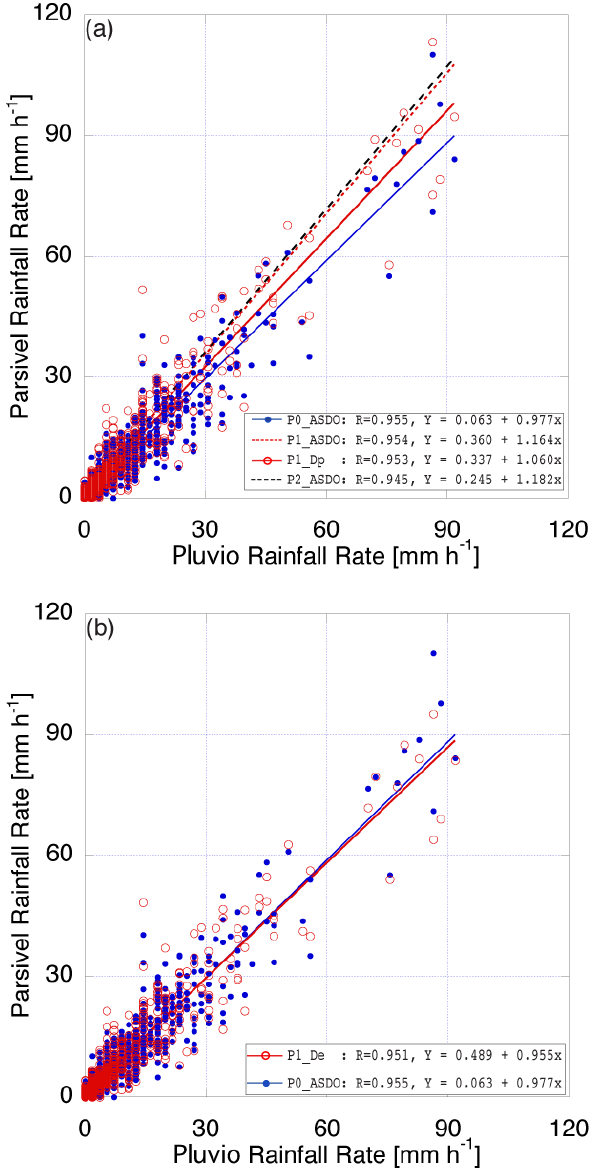
Fig. A1. Scatter plots of the rainfall rate for the Parsivel ( P 0 and P 1 ) vs. the Pluvio measurements. Rainfall rates derived from the DSD measured by P 1 are plotted as open circles using the preset di- ameters ( D p ) in (a) and the re-calculated diameters ( D e ) in (b) , and rainfall data estimated by the on-board application software (ASDO) with P 0 are plotted as closed circles in both panels. The data were averaged over 1min. The lines represent linear regres- sions for each set of data as shown in the legends on the bottom with the correlation coefficients, R . The linear regressions for the data estimated by ASDO on P 1 and P 2 are also plotted with dashed lines for reference in (a)